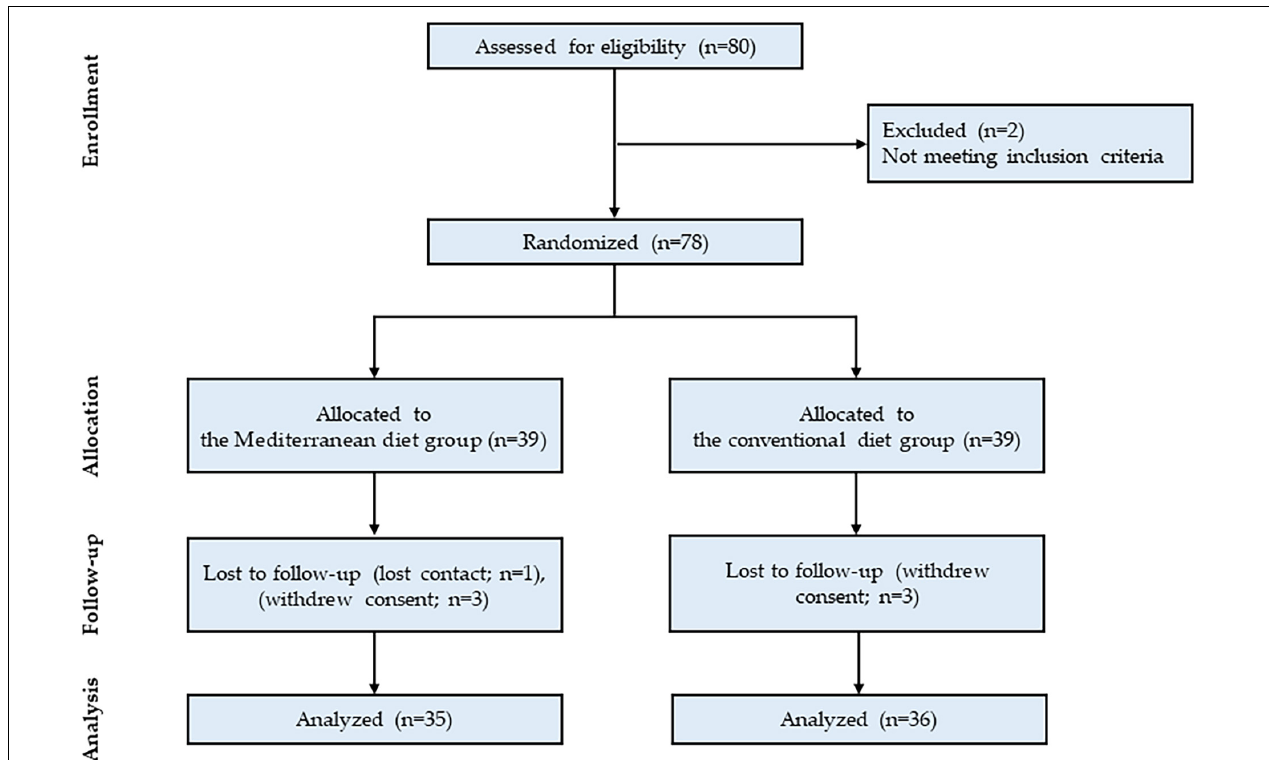
FIGURE 1 | Flowchart of the study participant selection process.